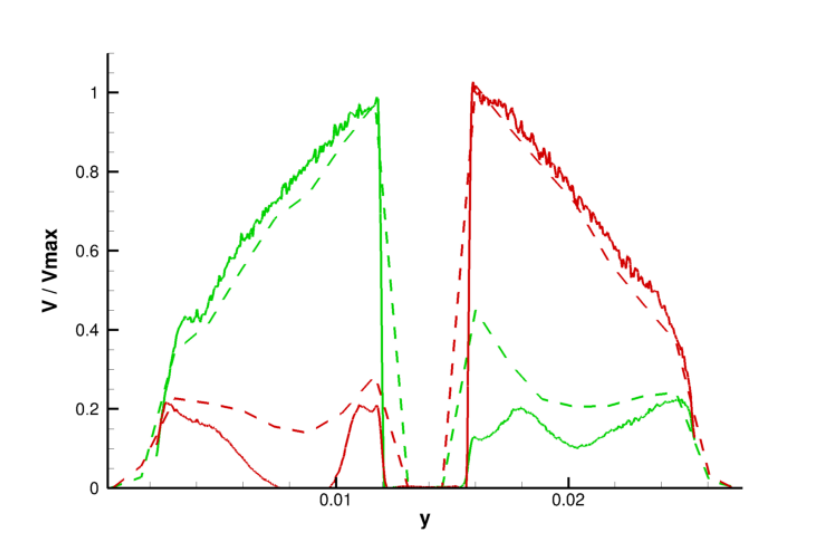
Figure 7. Comparison of exit velocity profile, normalized by the maximum velocity. The URANS results (dashed) and SST-DDES simulations (solid) are shown. Green lines represent the peak velocity snapshot for the left outlet nozzle, and red lines represent peak velocity for the right